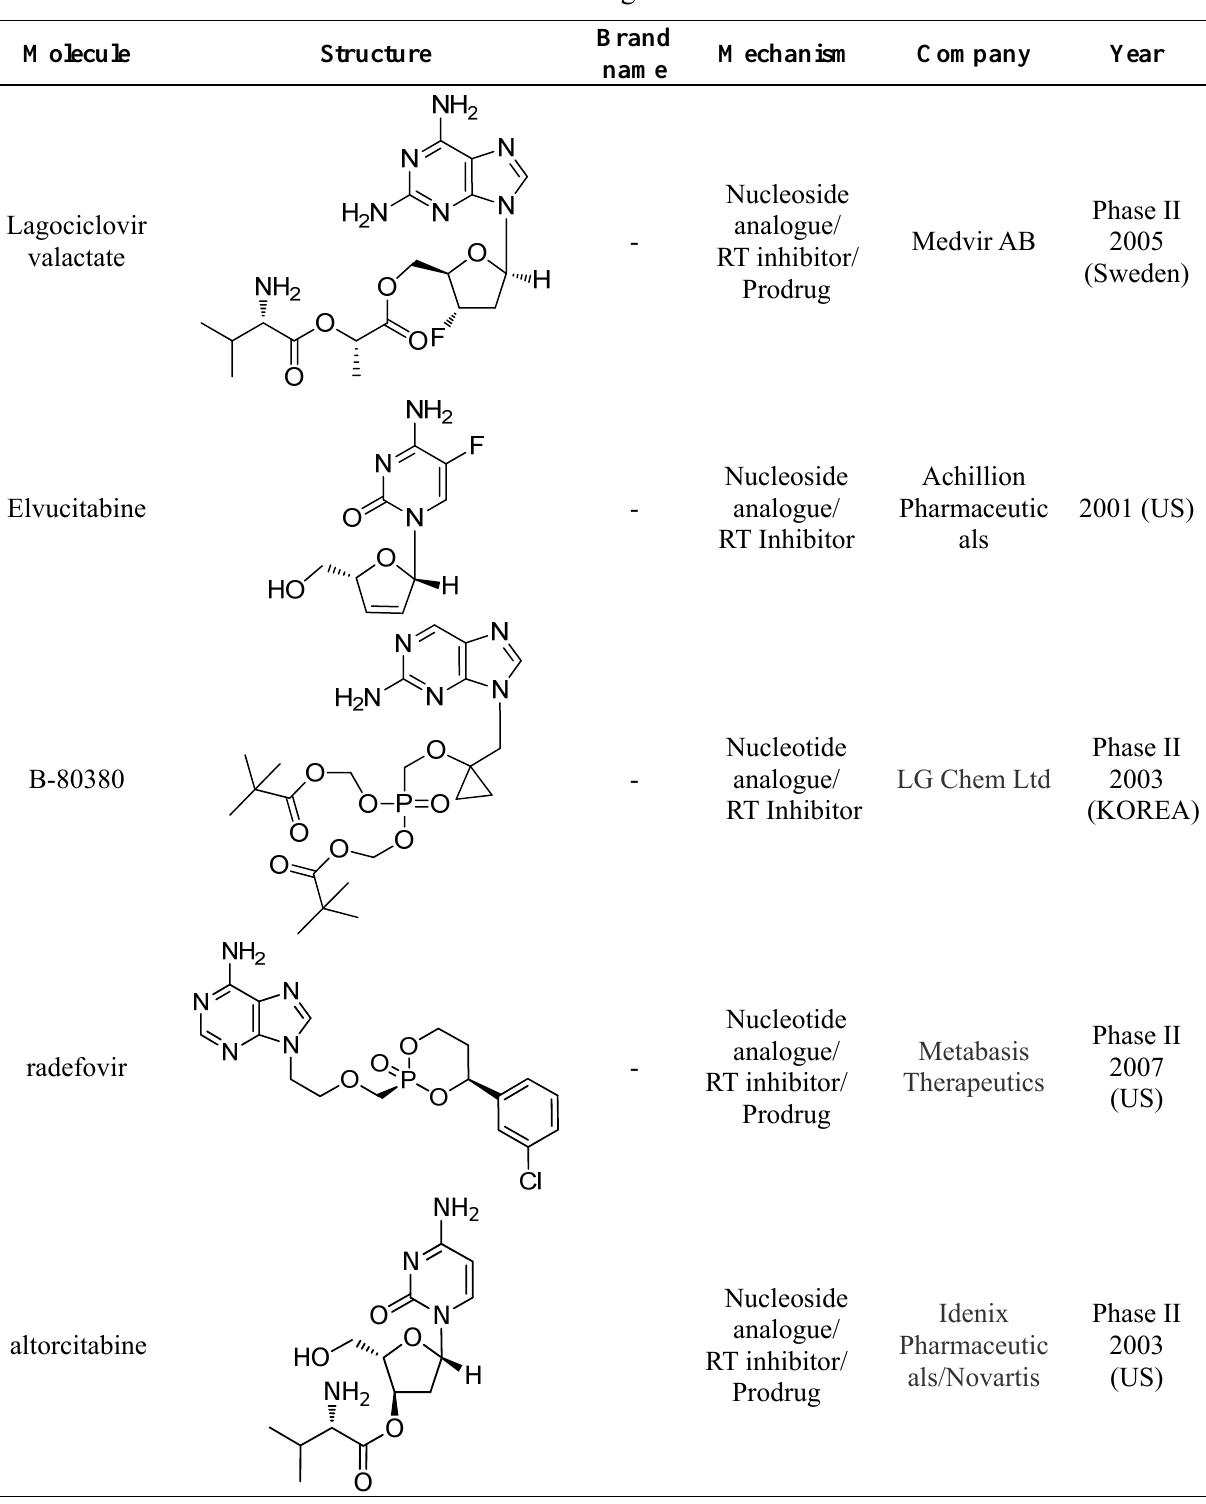
Table 2. Anti-HBV drugs in clinical